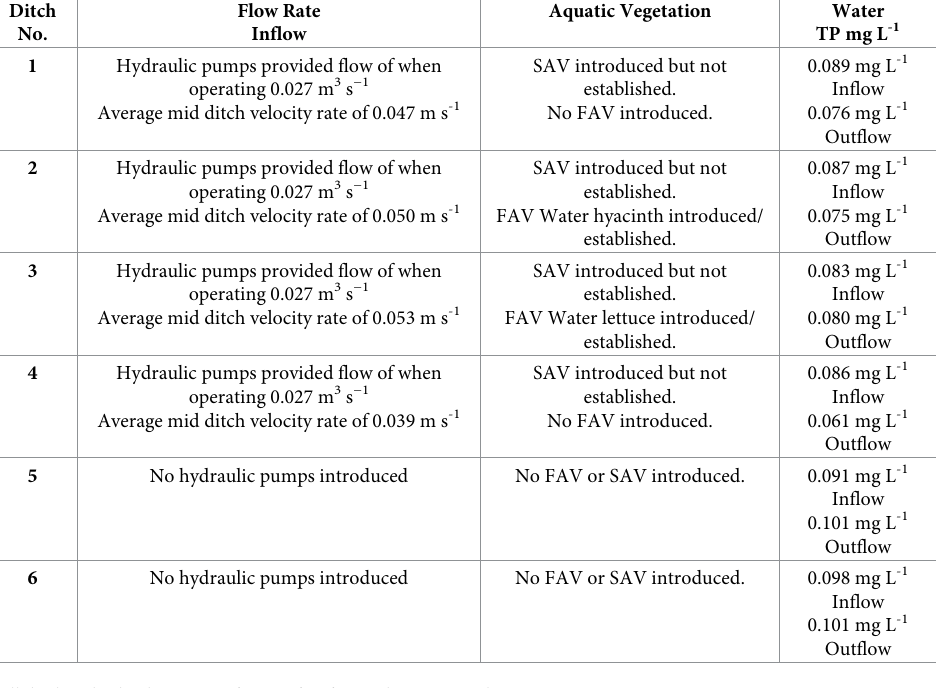
Table 3. Practices used throughout experiment regarding flow rate, dredging, aquatic vegetation, and water total phosphorus (TP) concentrations. Ditch